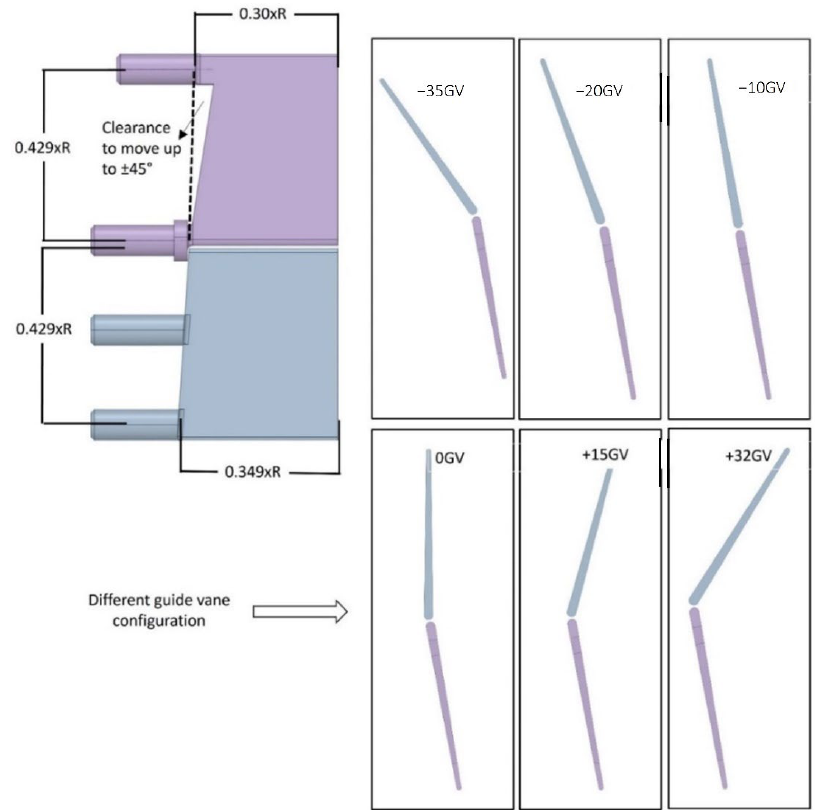
Figure 3. Computer-aided design (CAD) model of the GV system and different configurations investigated in the present study.